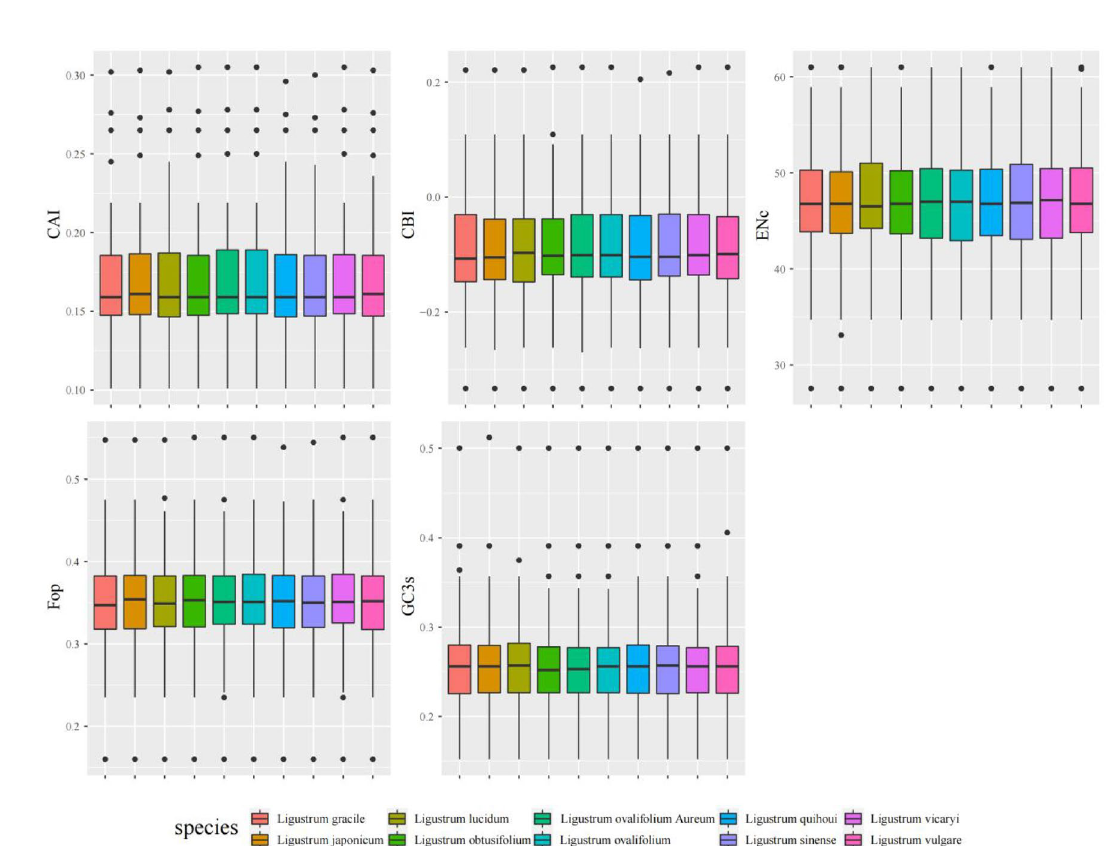
Figure 3. The comparative analysis of codon usage bias in 10 Ligustrum species, including Codon adaptation index (CAI), Codon bias index (CBI), Frequency of optimal codons index (Fop), Effective number of codons (ENc), GC of synonymous codons in third position